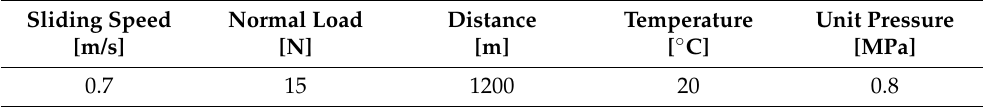
Table 3. Designation of samples and friction pairs used in tribological tests.